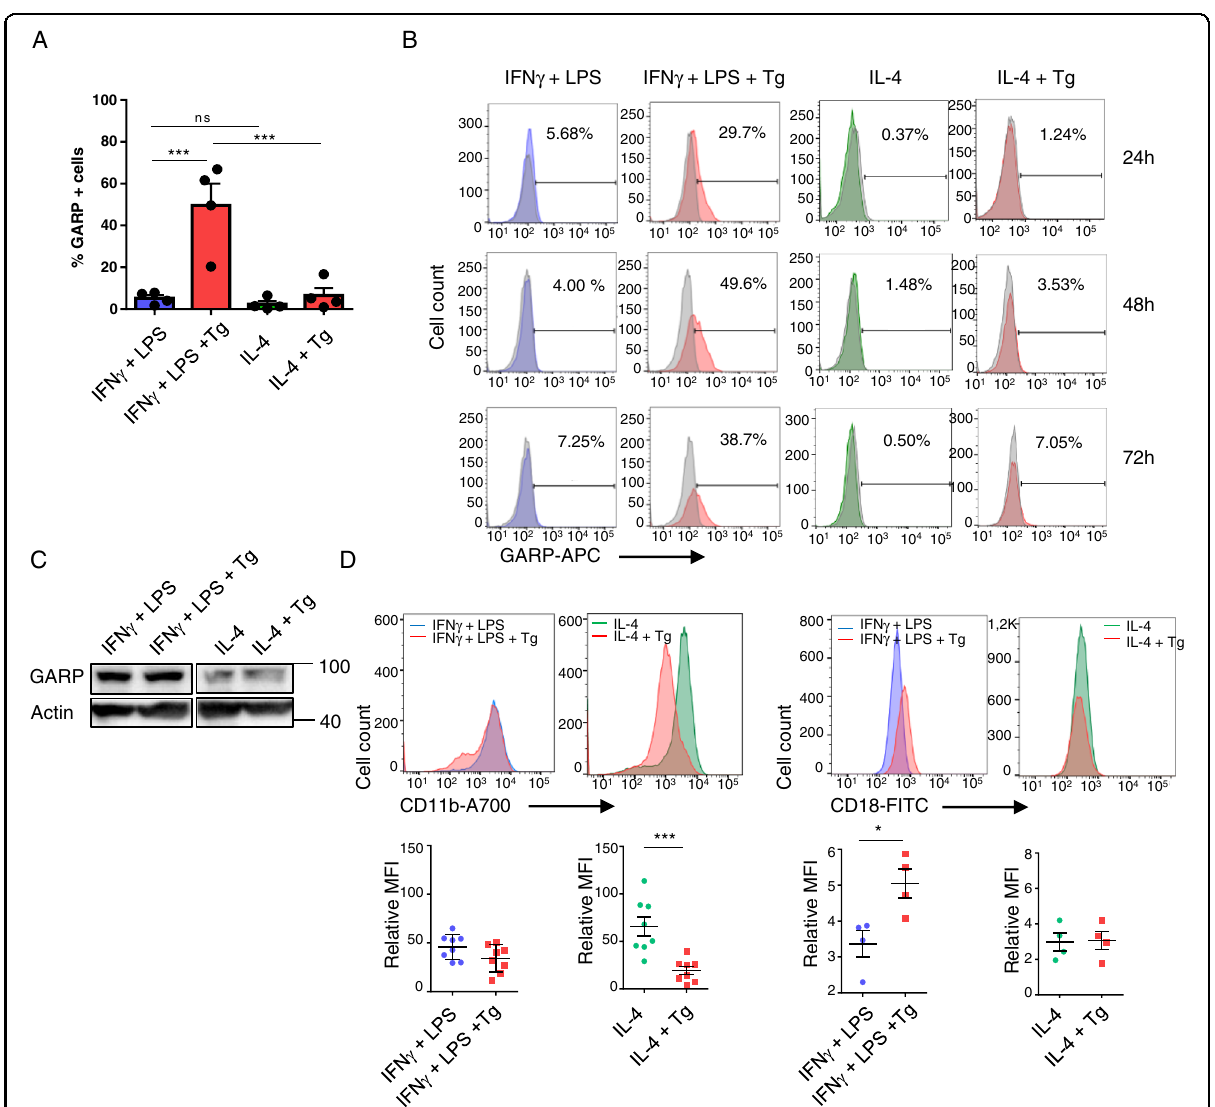
Fig. 4 GARP and CD11b expression on M1 and M2 macrophages. A FACS analysis of GARP membrane expression on M1 and M2 macrophages treated or not with Tg ( n = 4). B Kinetics of GARP expression on M1 and M2 macrophages treated or not with Tg for the indicated times ( n = 3). C GARP analysis by western-blot in M1 and M2 macrophages treated or not with Tg (a representative image is shown; n = 2). D CD11b ( n = 8) and CD18 ( n = 4) membrane expression on M1 and M2 macrophages treated or not with Tg (* p < 0.05; ** p < 0.01; *** p < 0.005; **** p <